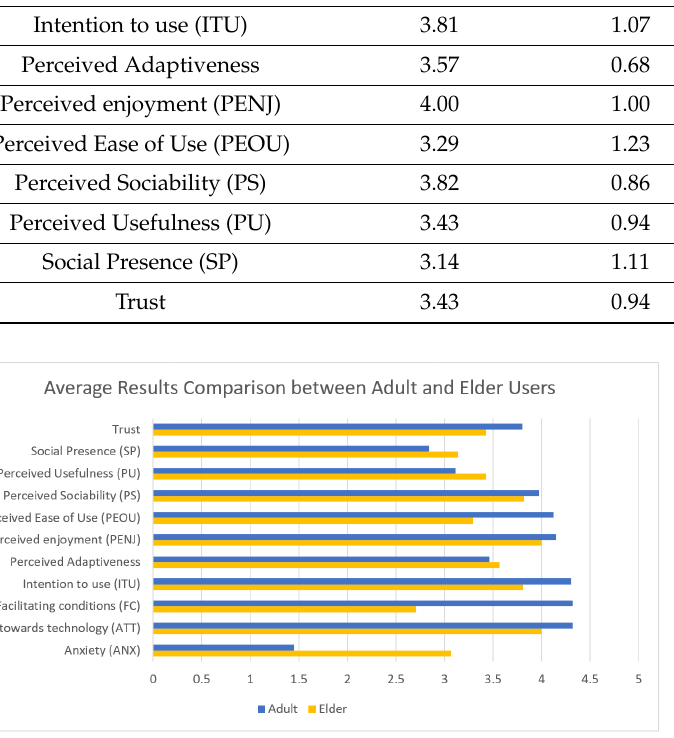
Figure 8. Average Results Comparison between Adult and Elderly Users.